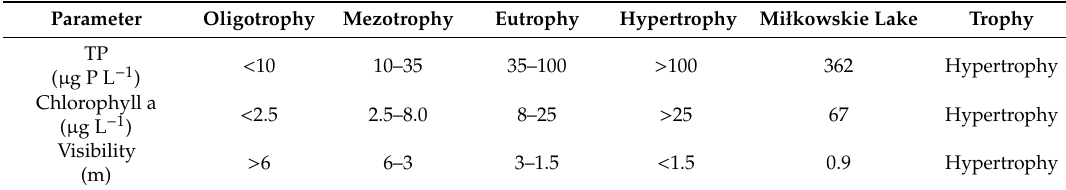
Table 4. Classification of water trophies of Miłkowskie Lake based on the 2018 results (OECD 1982). Table 5. The trophic status index (TSI) calculated for Mi ł kowskie Lake on the basis of the visibility (SD), chlorophyll concentration (Chl), total phosphorus (TP) and total nitrogen (TN) in 2018.